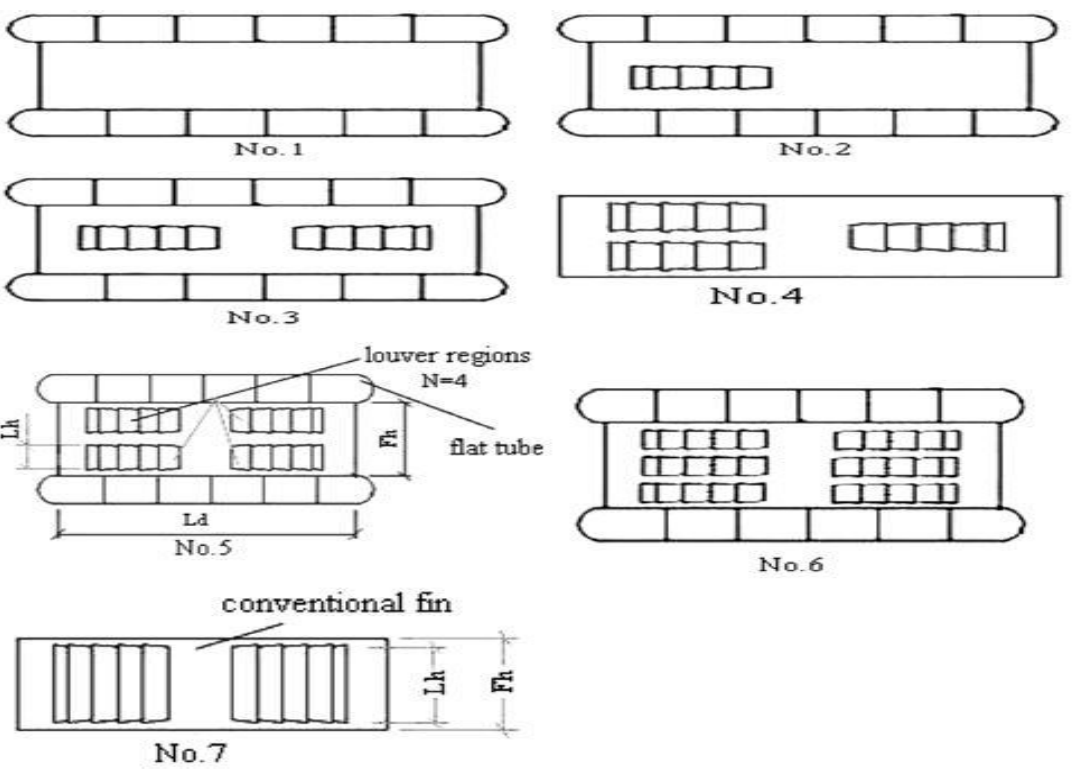
Figure 9: Multi region louver fin patterns [14].